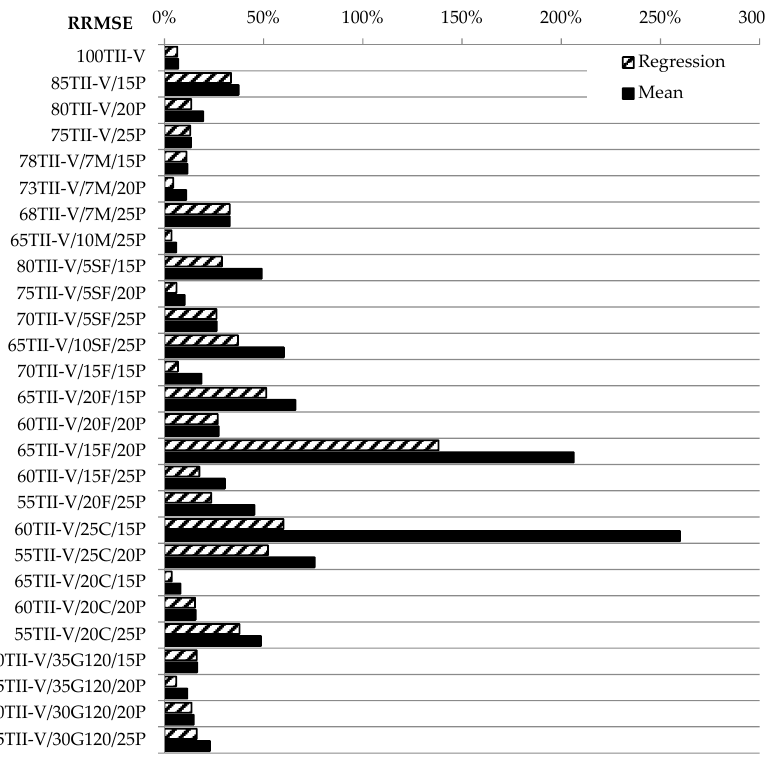
Figure 10. The relative error of the approximation RRMSE of the mean and regression. The higher the difference between these two approaches is, the worse is the fit by average variation coefficient. There is a large difference between the accuracy of both methods on the mixture 60TII-V/25C/15P. There is also a visible difference for several other mixtures between the two methods (70TII-V/15F/15P, 73TII-V/7M/20P, and 65TII- V/20C/15P), where the difference is higher than 50%. Based on the above mentioned, it is not suggested to use the approximation with the mean value for these mixtures. It should be noted that relations between the amount of SCM and the resulting variance of the data are not observed. It can be seen that the RRMSE values for mixtures 60TII-V/25C/15P and 65TII-V/20C/15P are very high. The difference is more than 100% comparing the RMSE to the mean value of the coefficient of variation, especially for the mean